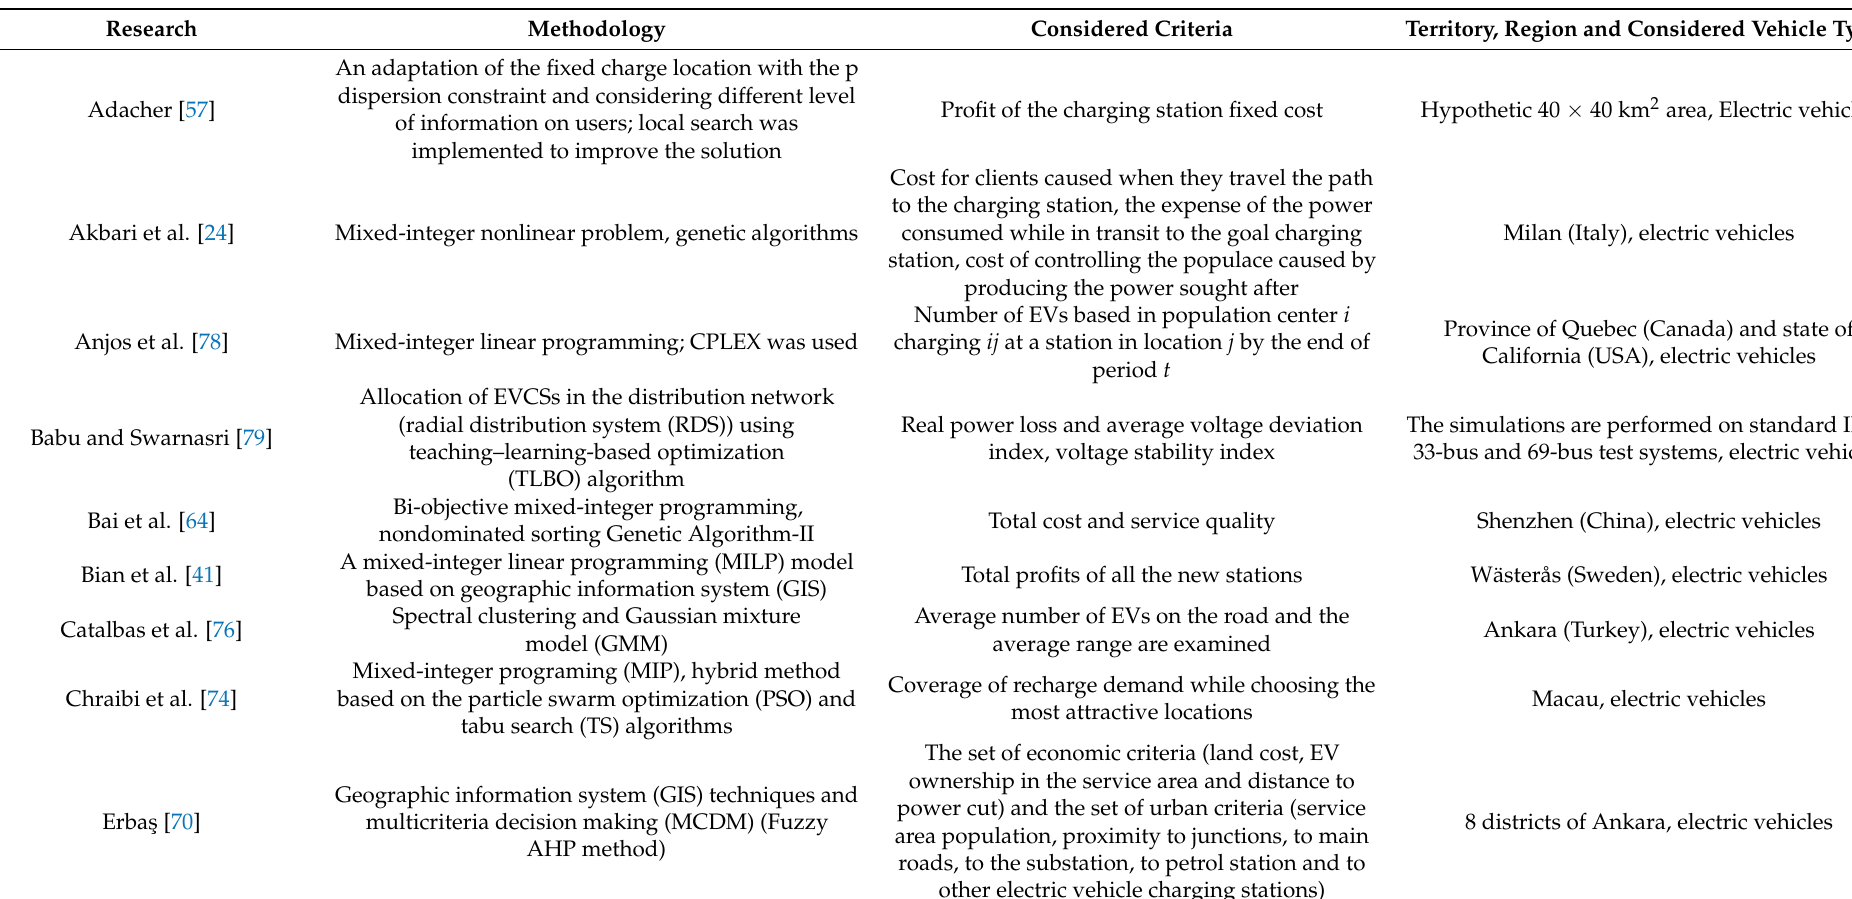
Table A1. The register of key research on EVCS location decision